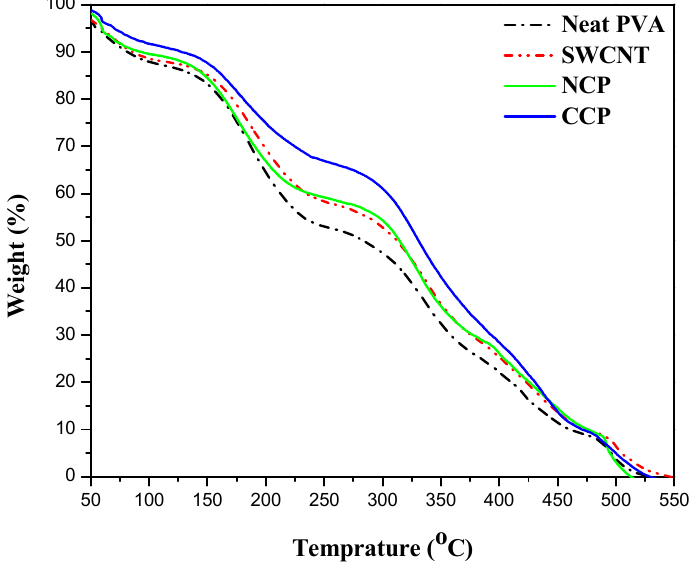
Figure 8. Comparison of thermal stabilities of neat PVA, SWCNTs, CCP 3, and NCP 3 .